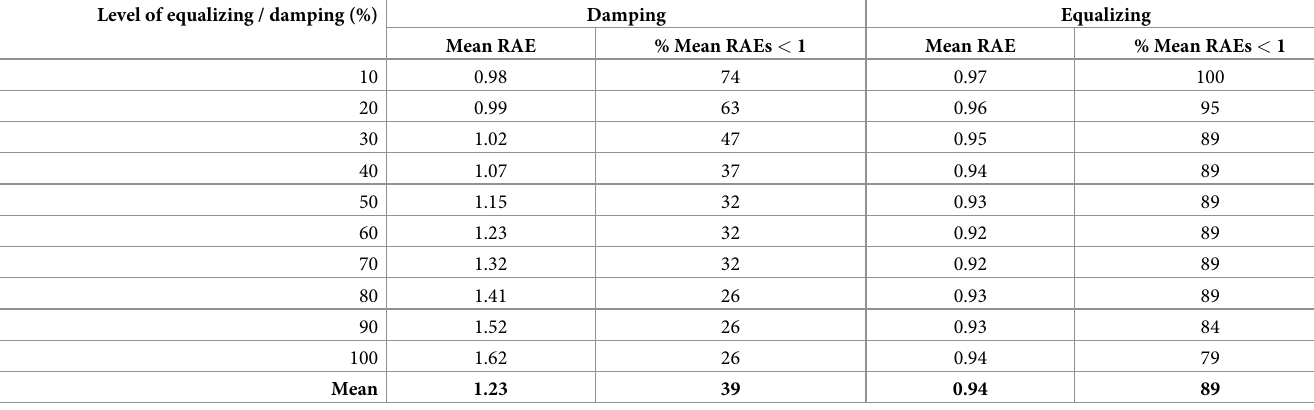
Table 2. Effect of damping and equalizing on forecast errors relative to original forecast errors. Level of equalizing / damping